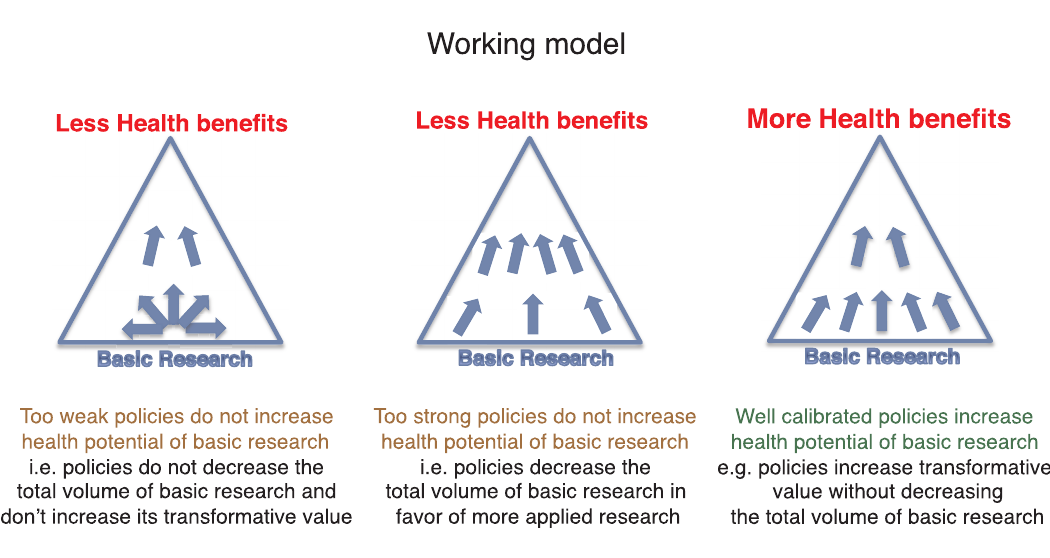
Figure 8. Schematic representation of the principles to increase the health benefit potential of basic biological and biomedical research . In order to increase the health benefits to society from basic “bio” research, policies should produce a good integration between “pure” basic, “use-inspired” basic, translational and applied research. The transformative value of basic science could be increased in several ways (see main text and Box 1 for more details). The directions of the arrows are intended only to express the capacity of tr ansformative value of research (arrows pointing towards the top vertex of the triangle have maximum transformative value) and are not intended to reflect neither the quality of research nor the status of “basicness”.